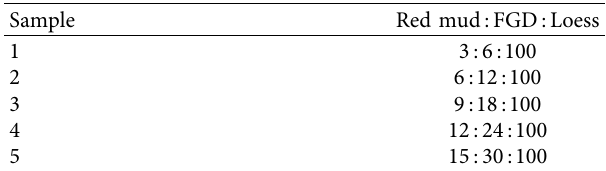
Table 3: Proportion of the mixture. Sample